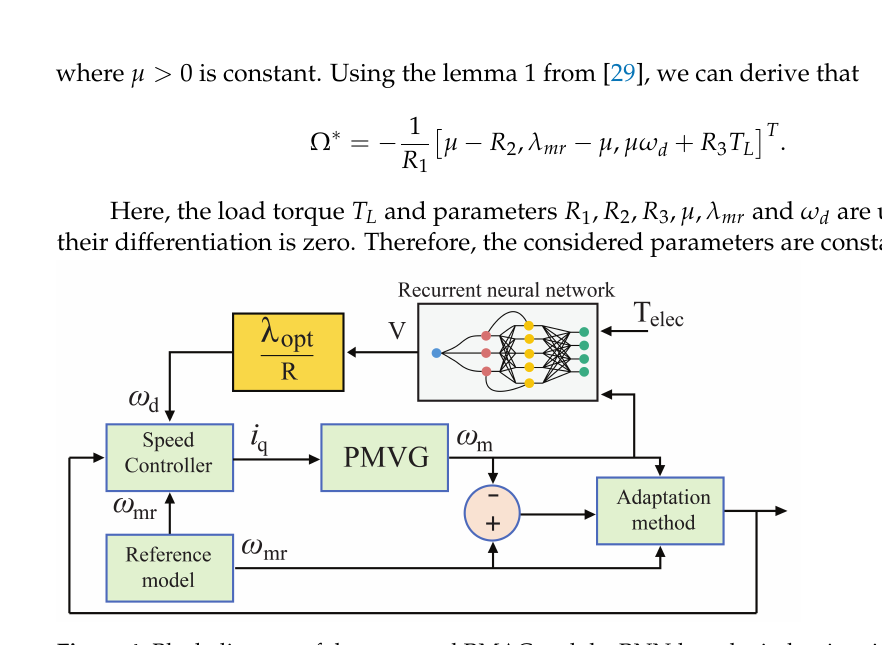
Figure 4. Block diagram of the proposed RMAC and the RNN-based wind estimation